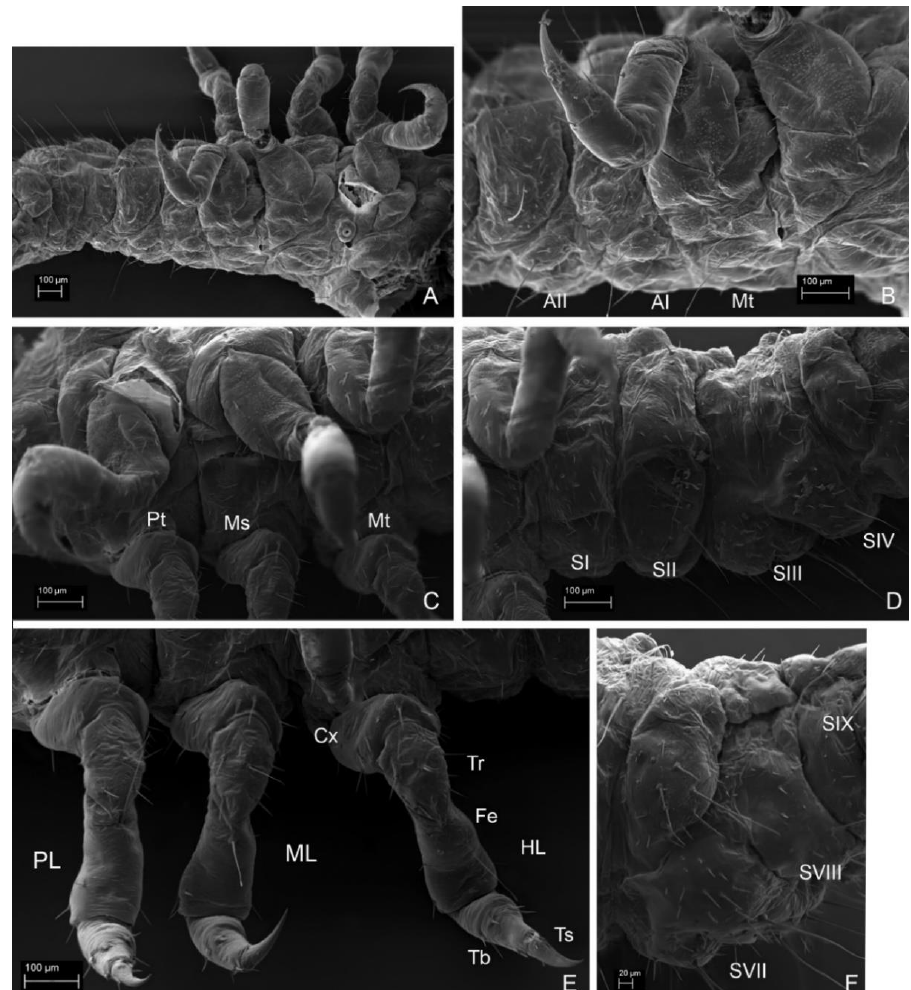
Figure 12. Leiodes cinnamomea. Details of larval morphology of instar I. ( A , B ) Ventro-lateral side of thorax and part of abdomen. ( C , E ) Legs. ( D , F ) Abdomen. Abbreviations: AI, II—abdominal segment